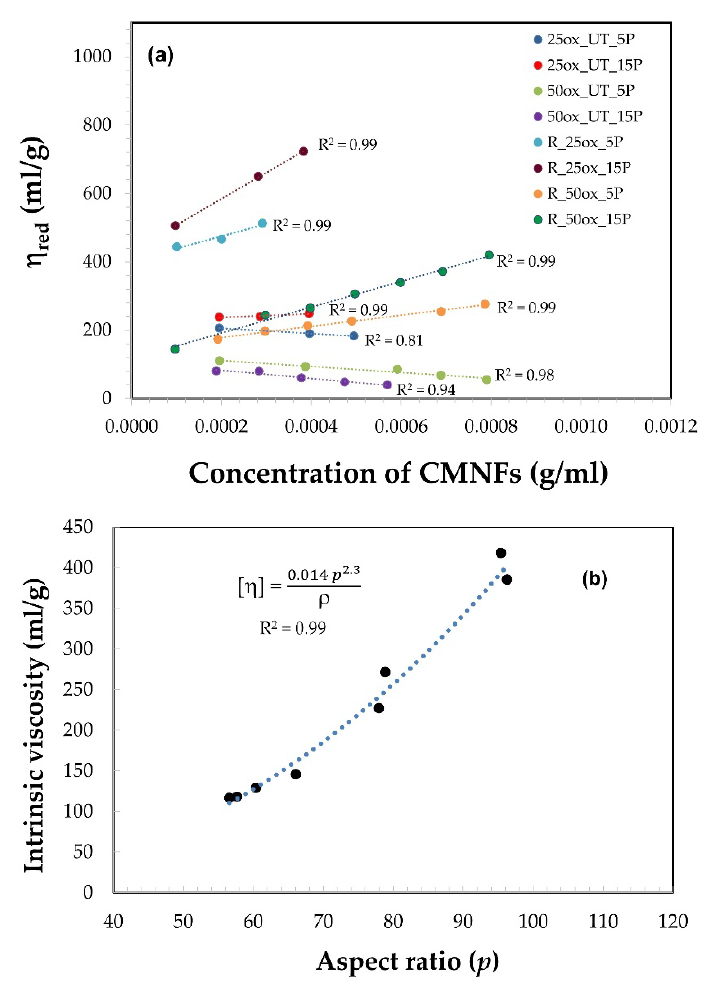
Figure 7. ( a ) Variation in the reduced viscosity according to the concentration of CMNFs in the dilute region, and ( b ) Intrinsic viscosity of the CMNF suspensions as a function of the aspect ratio (p) and the fit with a potential trend represented by a dotted line.